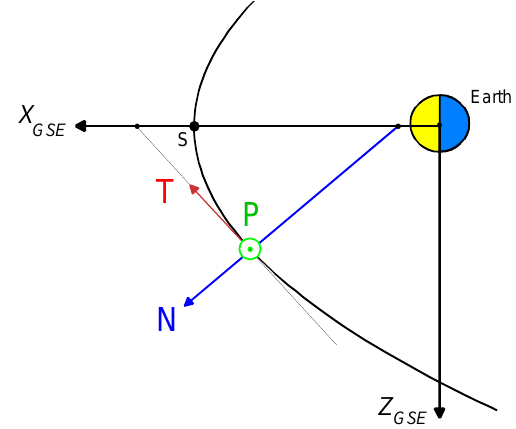
Fig. 4. Sketch showing the TPN (tangent, perpendicular, nor- mal) coordinate system. T and P are tangent and N normal to a paraboloid passing by the spacecraft and by the subsolar point de- fined from the Tsyganenko 89 model taken for the Kp of the day of the event. Table 1. Top: directions (in GSE) of the axis of variance obtained from MVA applied to flux gate data during Mp crossing. Bottom: direction (in MVA frame) of the TPN axis (see Fig. 4 and text). λ 1 λ 2 λ 3